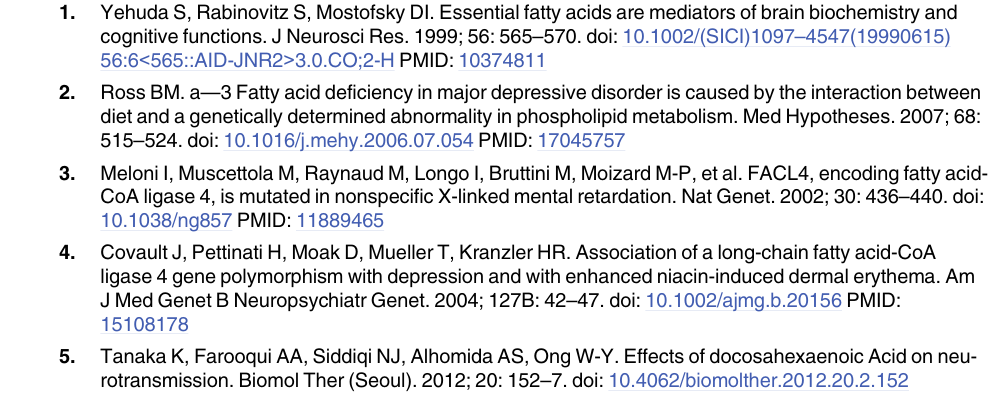
S2 Fig. Absolute amount of fatty acid contents in fly heads. Data represent the average of 3 groups of 30 heads. (TIF) S3 Fig. Negative geotaxis assay. Flies raised on various food sources have no defects in their sensorimotor responses. The negative geotaxis assay was performed as described before but with minor modifications [1]. Breefly, 2 – 9 days old male CantonS flies were banged to the bot- tom of a tube during 10 seconds. and were given the chance to climb to the top of a 15 cm long tube. The climbing index indicates how many flies (%) were able to climb 2 cm within the next 7 seconds. Data represent mean ± SEM. (N = 5 groups of 21 – 22 flies, ns = p > 0.05). [72] (PDF) S1 Table. Fatty acid contents in walnut oil and linseed oil. (TIF) S2 Table. Absolute amount of fatty acid contents in fly heads (in μ g/head). Data represent the average of 3 groups of 30 heads. S3 Table. Statistics. (A-B) Detailed statistical values corresponding to data shown in Fig 2A and 2B. (C-E) Detailed statistical values corresponding to data shown in Fig 3B: SNP, “ on ” - transient, and “ off ”